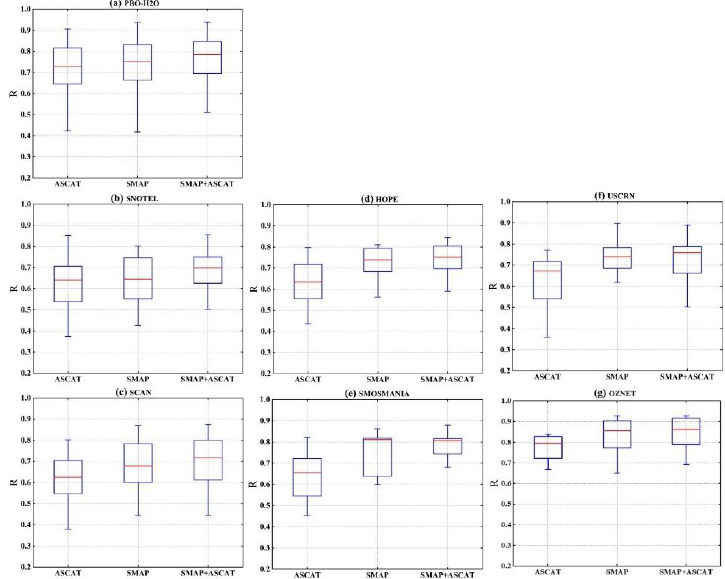
Figure 7. Box plots of correlation coefficients of SMAP+ASCAT, SMAP, and ASCAT SM products against the in-situ SM observations of different ISMN networks: ( a ) PBO-H2O; ( b ) SNOTEL; ( c ) SCAN; ( d ) HOPE; ( e ) SMOSMANIA; ( f ) USCRN; and ( g ) OZNET.